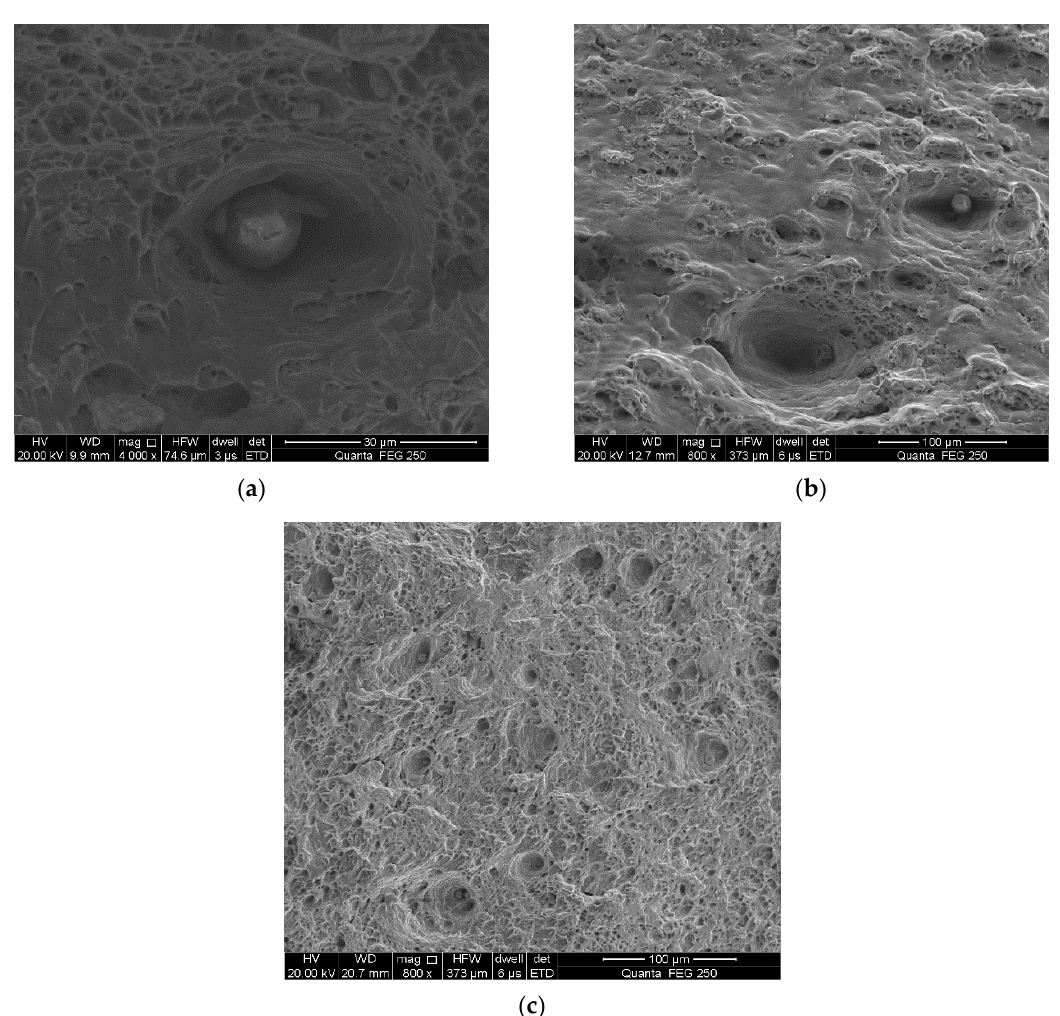
Figure 8. The fatigue fracture region of the alloy with strain amplitude of ±0.5% ( a ) air, ( b ) mixed chloride salt, and ( c ) mixed sulfate salt.